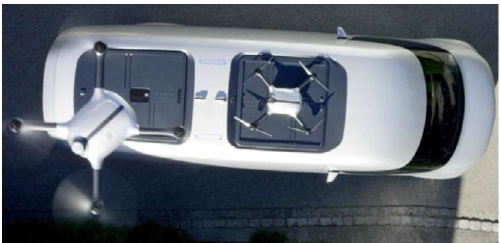
Figure 4. Drone delivery from truck